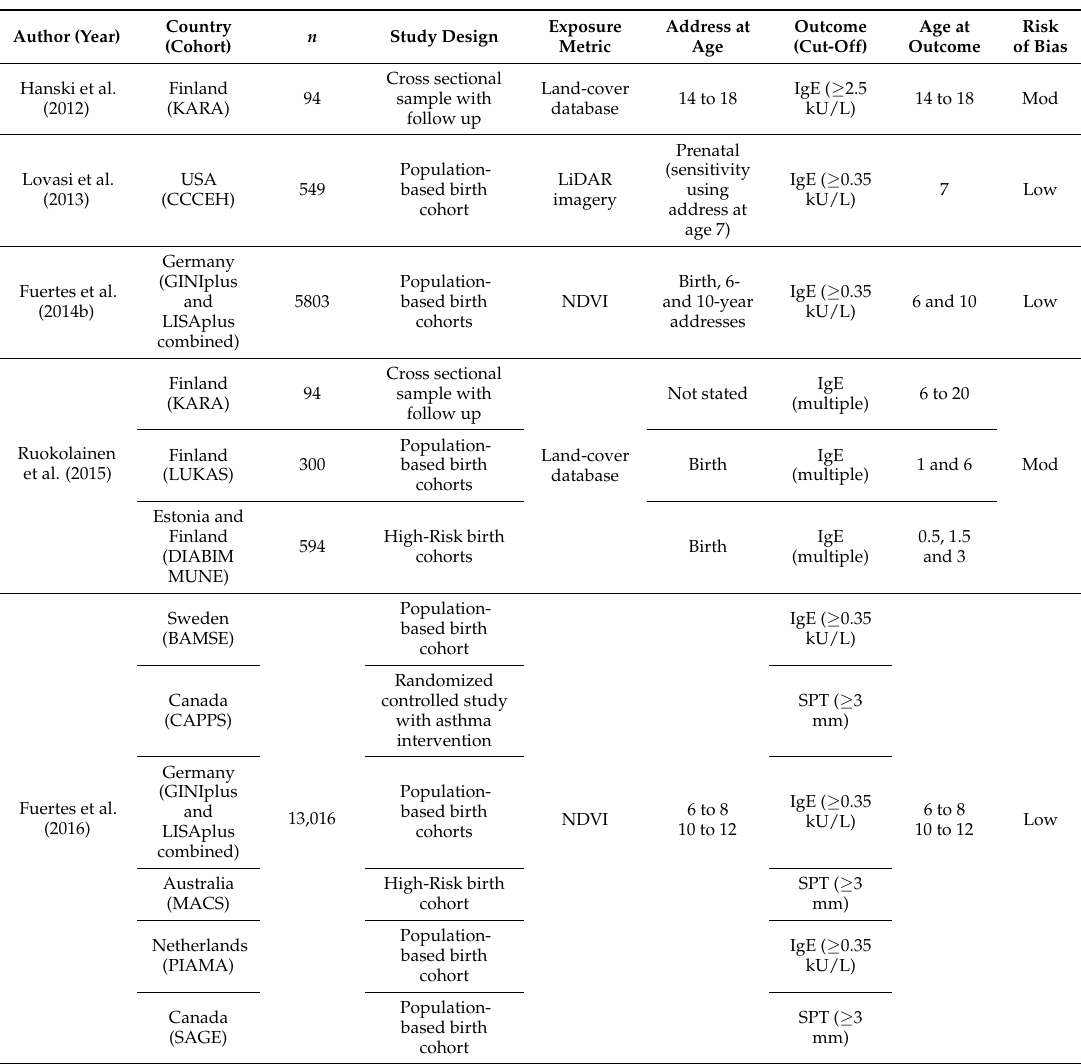
Table 1. Characteristics of included